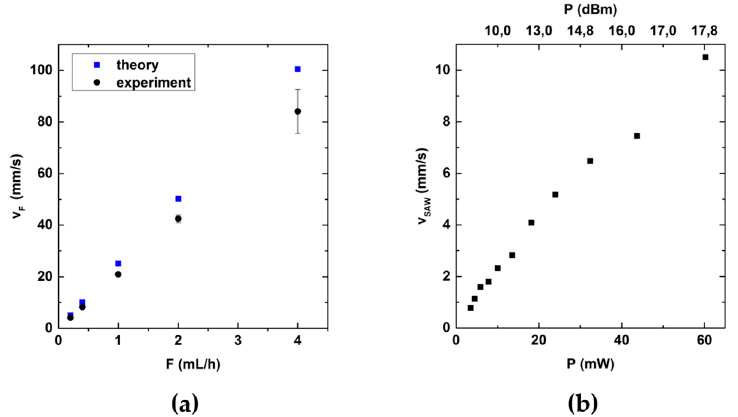
Figure A1. ( a ) Maximal flow velocity in the center of the channel as being measured and calculated; ( b ) Induced SAW-streaming velocity in a bulk volume (compare Figure 4a) parallel to the chip surface as a function of SAW power.